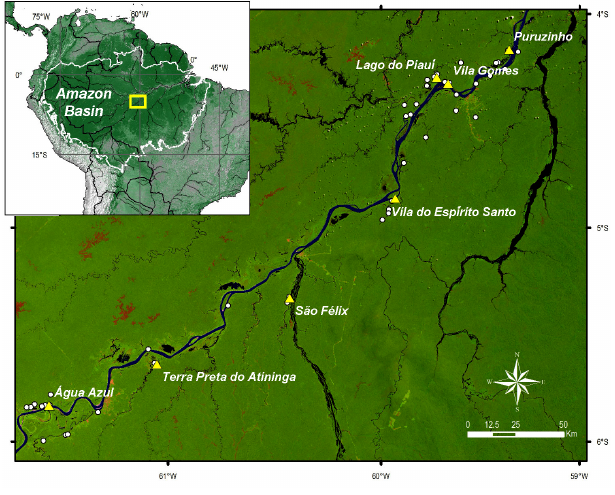
Fig. 1 . Location of study sites along the middle and lower Madeira River, Central Amazonia, Brazil. White dots show visited patches of Amazonian dark earths (ADE), and triangles show the seven villages where in-depth research was